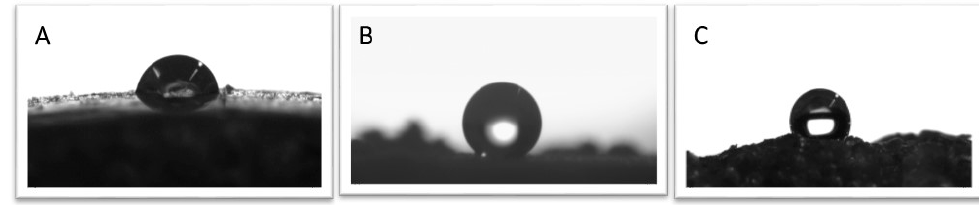
Figure 5. The water contact angle of ( A ) unmodified PU is 85.5°, ( B ) C18-DE is 137.2° ( C ) C18-DE-PU is 129.8°.